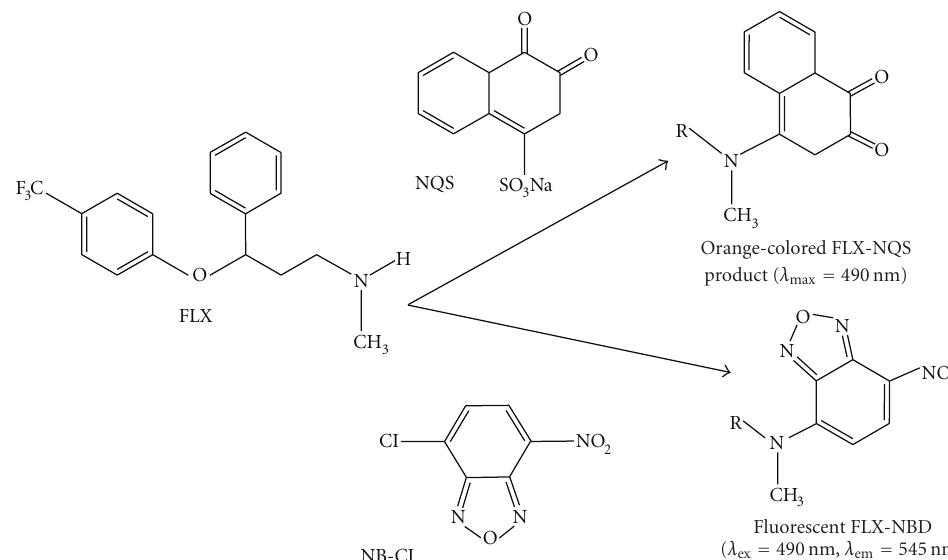
Figure 8: Scheme for the reaction pathway of FLX with NQS and NBD-Cl.